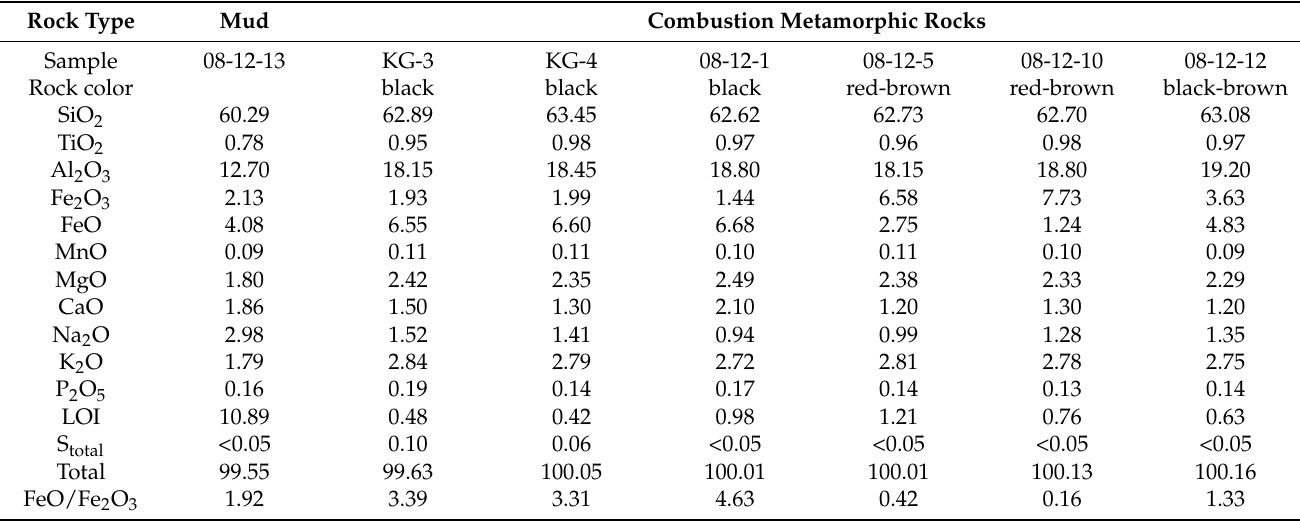
Table 1. Major-element compositions (in wt%) of typical combustion metamorphic rocks and repre- sentative unaltered mud samples from Karabetova Gora MV (Taman Peninsula).